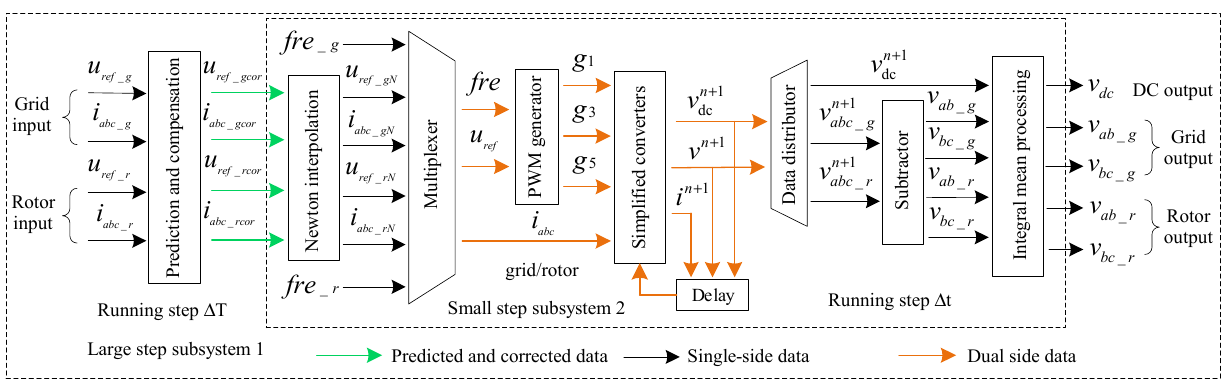
Figure 11. Block diagram of FPGA resource optimization for back-to-back converters.